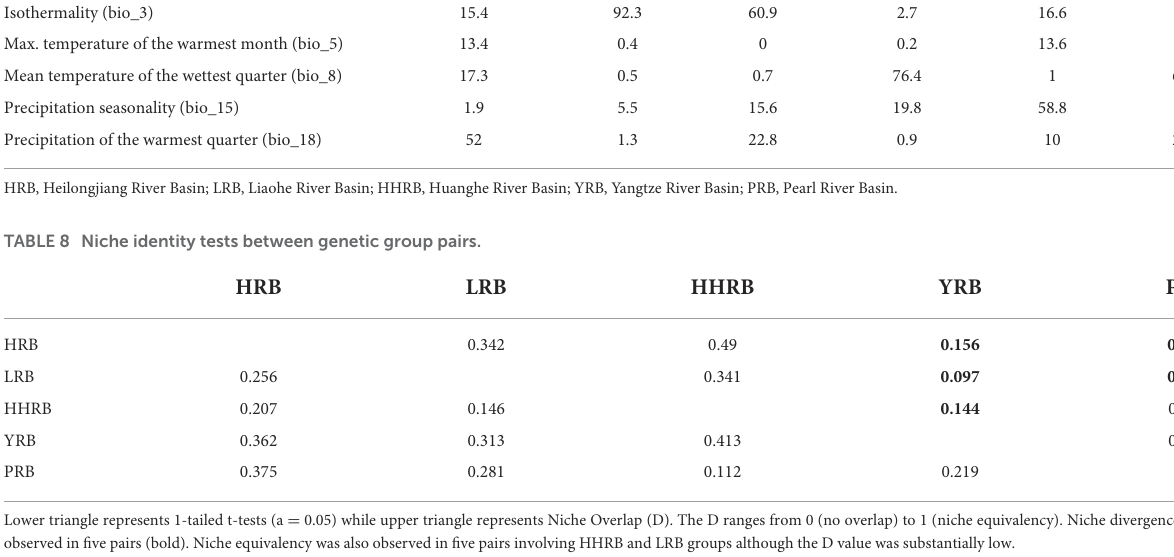
TABLE 7 Percentage contribution of bioclimatic variables across six ecological niche models (ENMs). Variable